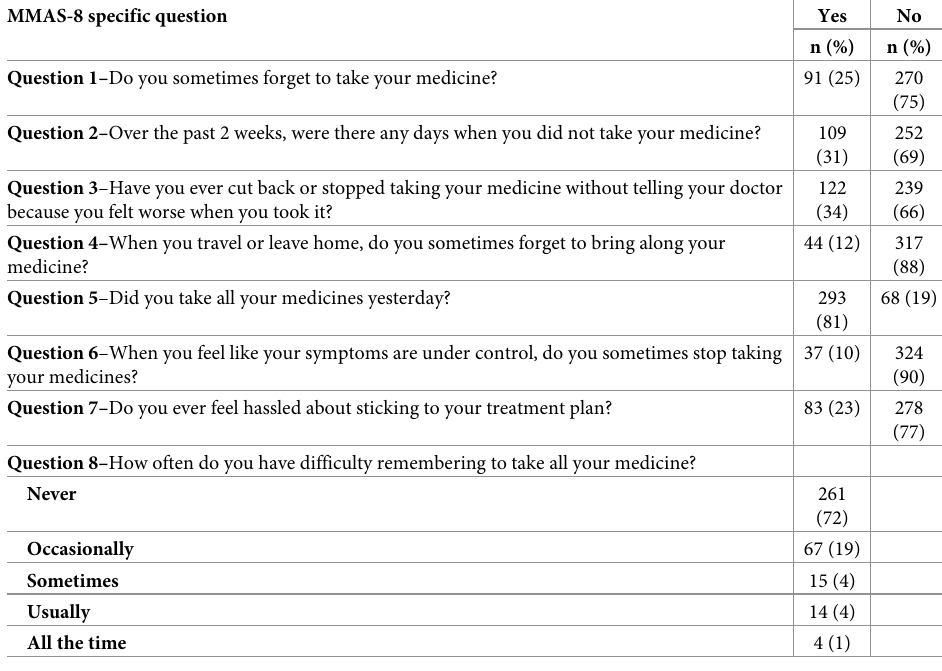
Table 2. Proportion of yes/no responses to the MMAS-8 questions by the study participants, Shatila primary care clinic, Beirut, October 2018. MMAS-8 specific